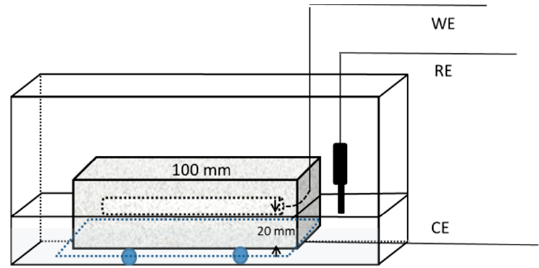
Figure 1. Schematic diagram of corrosion test.